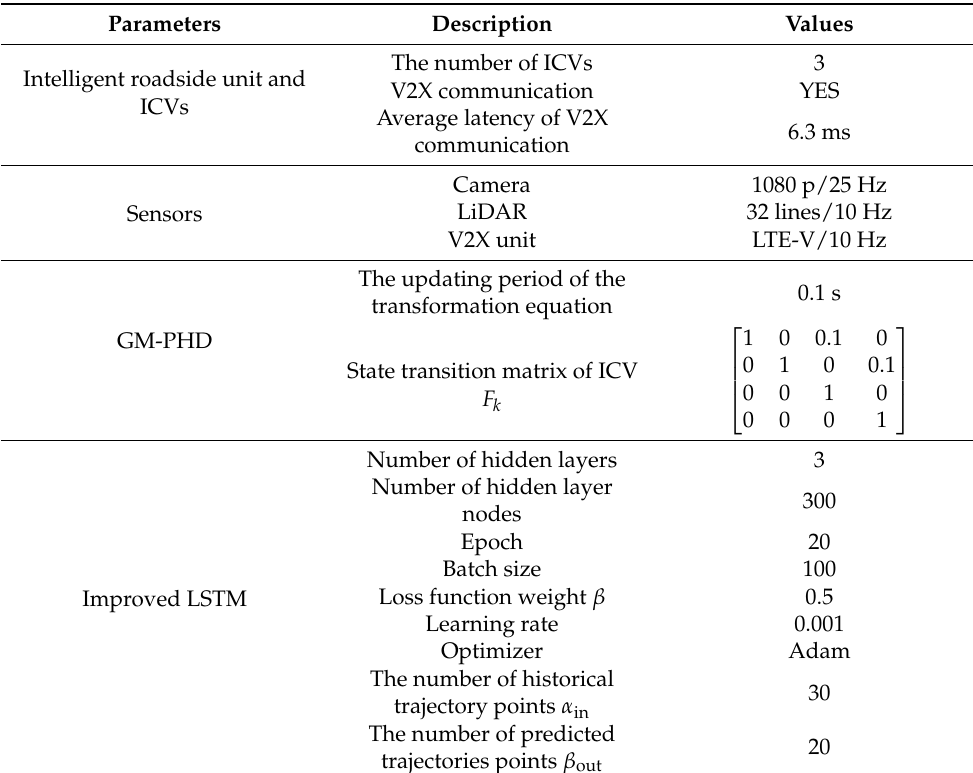
Table 3. List of